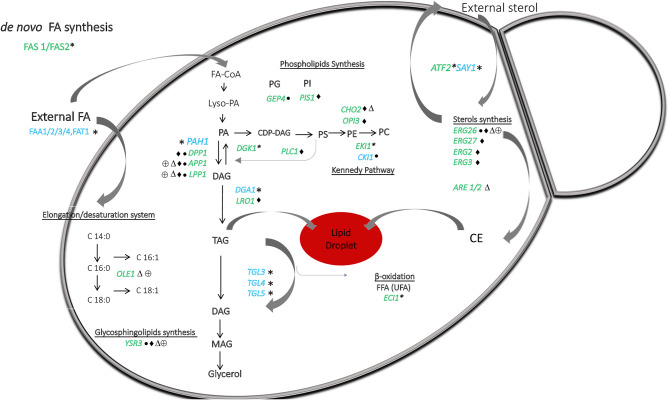
A general overview of the lipid metabolism in Malassezia, based on lipidomic and in silico genomic analysis presented in Figure 1 and Table 1. Malassezia species are lipid dependent due to the lack of fatty acid synthase (FAS1/FAS2). External sources of free fatty acids are taken up and activated by the acyl-CoA synthases FAA1/2/3/4. Δ9-desaturase (OLE1) catalyzing the conversion of saturated to unsaturated fatty acids was absent in M. globosa and M. restricta. The presence of phosphatidate phosphatase PAH1 can replace the lack of DPP1, LPP1, and APP1 to allow production of DAG from PA and to form TAG in lipid droplets. PA can normally be resynthesized from DAG by DGK1, but this gene was absent in all strains. Genes implicating in phospholipids synthesis involved CDP-DAG as a precursor were present in all strains. Importantly, in M. sympodialis, PIS1 involved in PI synthesis was absent as well as CHO2 and OPI3, which both are participating in the phosphatidylethanolamine N-methyltransferase pathway to form PC. GEP4 involved in PG synthesis was absent in M. pachydermatis, whereas this strain did contain CKI1 involved in PC synthesis but was absent in the other strains. ECI1 required to degrade unsaturated FAs was absent in all strains. Genes involved in sterol and sphingolipids synthesis were present in all strains, except ERG26 and YSR3, respectively, in M. pachydermatis, M. sympodialis, M. globosa, and M. restricta. Genes ERG27, ERG2, and ERG3 were only absent in M. sympodialis. ARE1/2 predicted to catalyze the acylation of ergosterol was absent in M. globosa. Lastly, sterol acetylation catalyzed by ATF2 was absent in all strains. Blue letters represent the presence and in green the absence of genes denoted by *All Malassezia strains, • M. pachydermatis, ♦ M. sympodialis, △ M. globosa, and ⊕ M. restricta. CE represents cholesteryl ester the species.